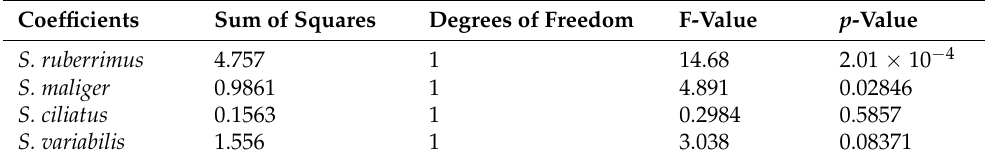
Table 4. Results from ANOVA test for δ 13 C across time for four rockfish species.